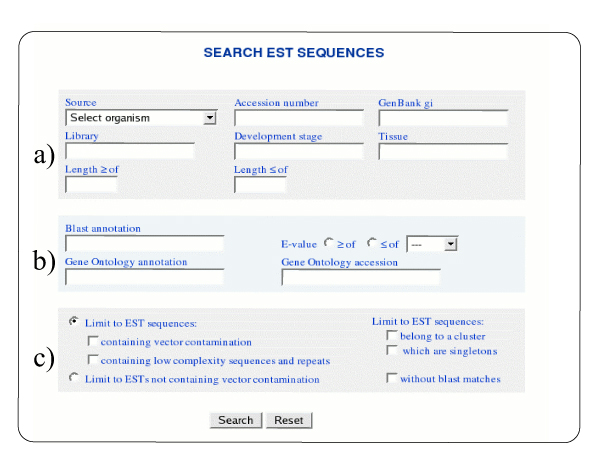
A screenshot of the EST Browser. ESTs can be retrieved by sequence features collected in the input step (a); by functional annotations (b); by specific properties reported by their processing.